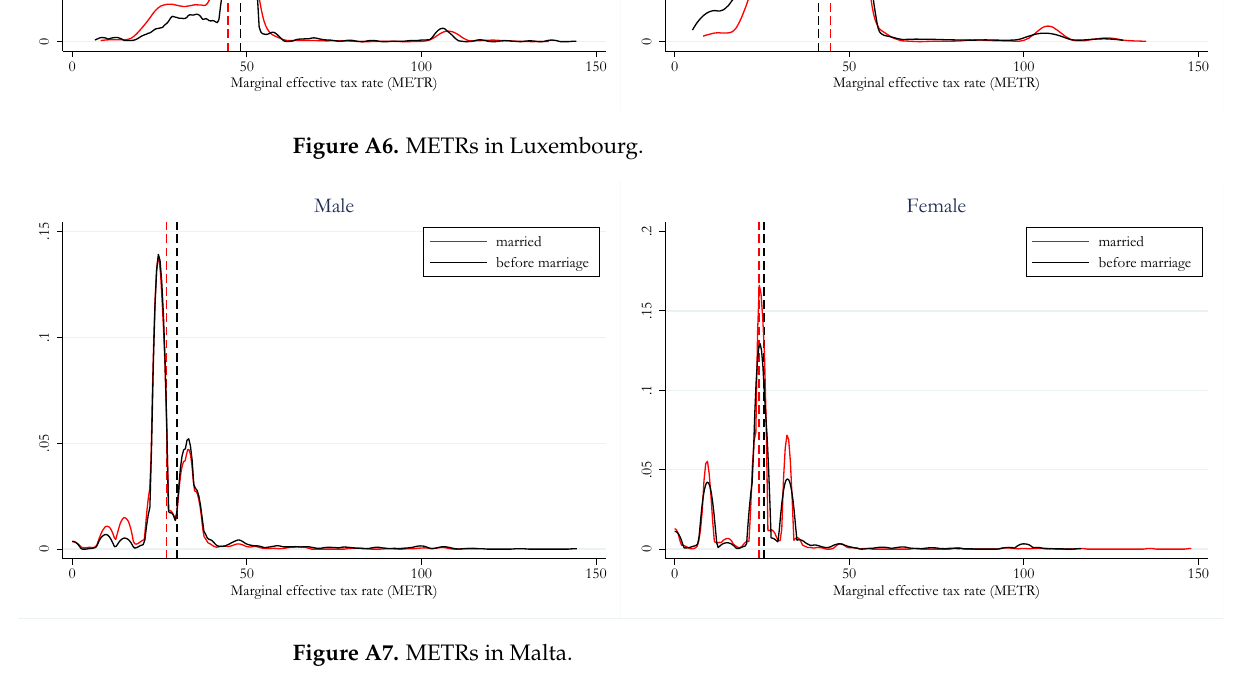
Figure A7. METRs in